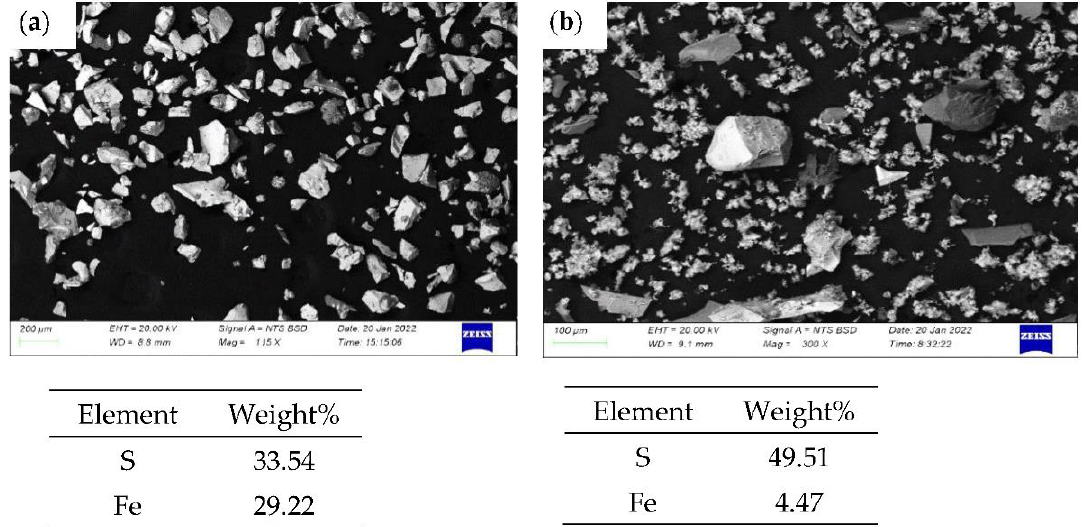
Figure 15. The backscattered SEM-EDS images of ( a ) pyrite before leaching and ( b ) after leaching in nitric acid.